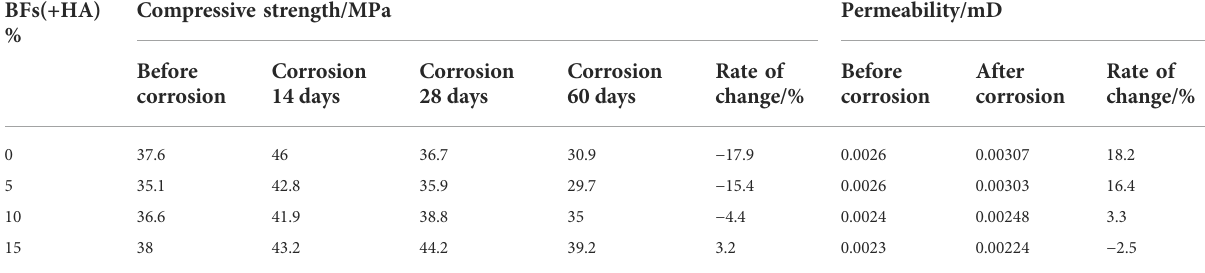
TABLE 6 Performance changes of composite emulsion cement paste before and after corrosion under different BFs-HA dosage. BFs(+HA) %